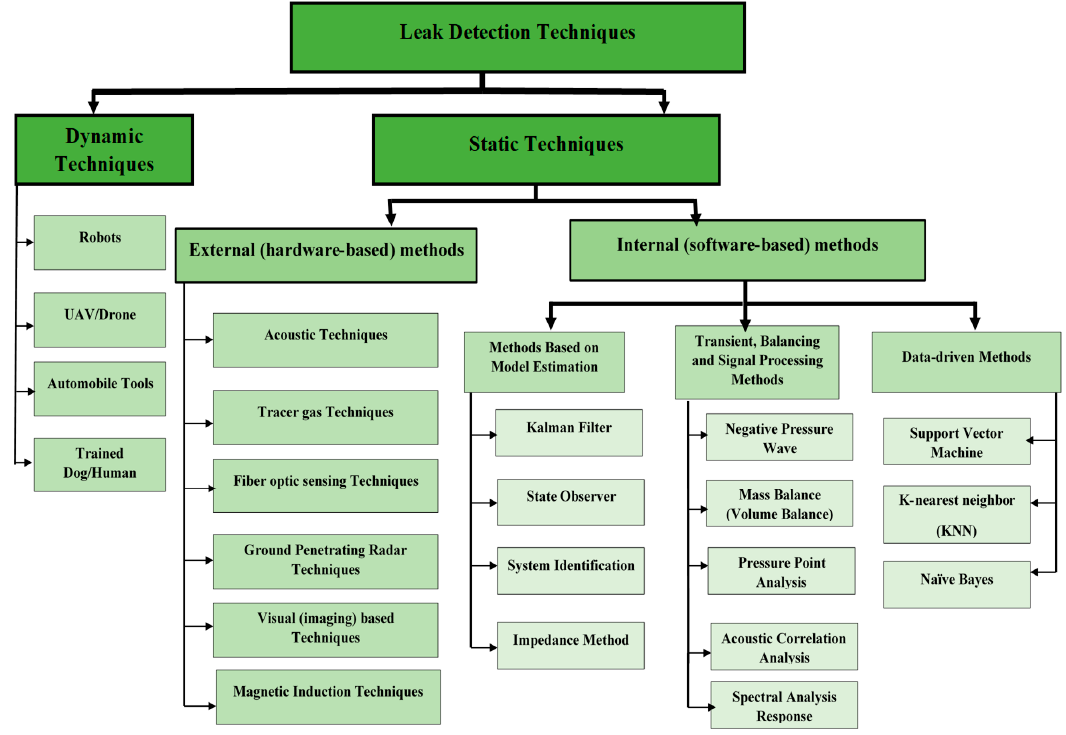
Figure 1. Classification of leak detection techniques.